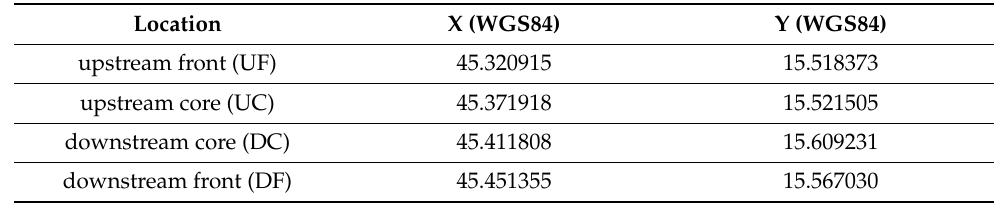
Table 1. Geographic coordinates of sampling sites along the invasion range of the signal crayfish in the Korana River in